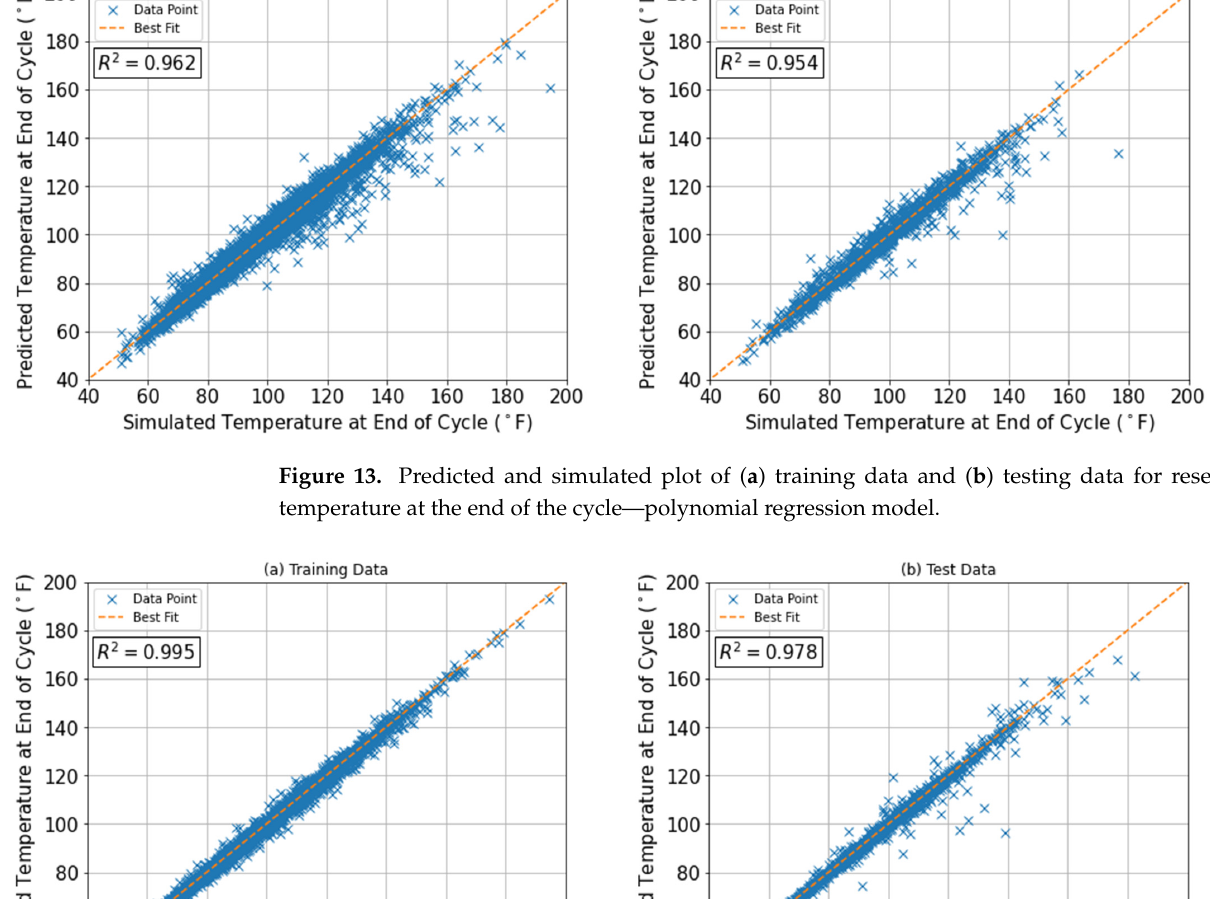
Figure 13. Predicted and simulated plot of ( a ) training data and ( b ) testing data for reservoir tem- perature at the end of the cycle—polynomial regression model.